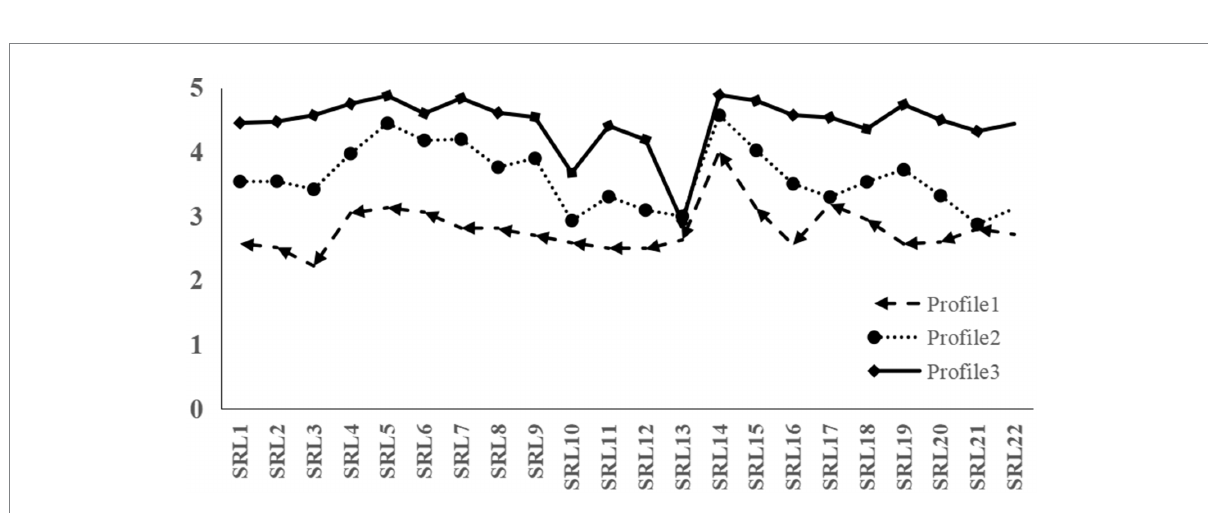
FIGURE 1 The three profiles of self-regulated learning by latent profile